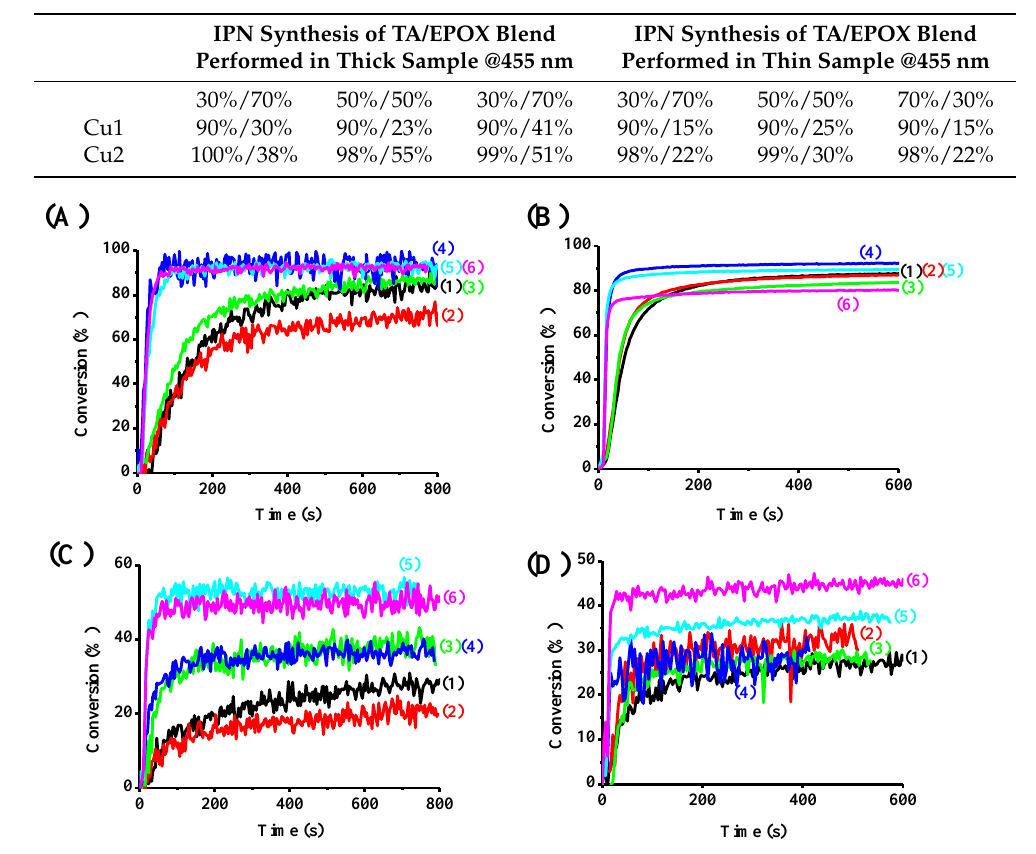
Figure 7. Photopolymerization profiles of acrylate functions ( A ) (thick sample), ( B ) (thin sample)) upon irradiation at 455 nm, and epoxide function (( C ) (thick sample), ( D ) (thin sample)) upon exposure to LED at 405 nm of TA/EPOX using Cu1/Iod/NPG (0.1%/1%/1% w / w / w ): (1) 30%/70%, (2) 50%/50%, (3) 70%/30%, and Cu2/Iod/NPG (0.1%/1%/1% w / w / w ): (4) 30%/70%, (5) 50%/50%, (6) 70%/30%. The irradiation starts at t = 10 s. Table 4. Final conversions of acrylate and epoxides functions for the IPN synthesis of TA/EPOX blend using Cu1 (or Cu2)/Iod/NPG (0.1%/1%/1%/ w / w / w ) as PIS upon exposure to visible light at 405 nm.